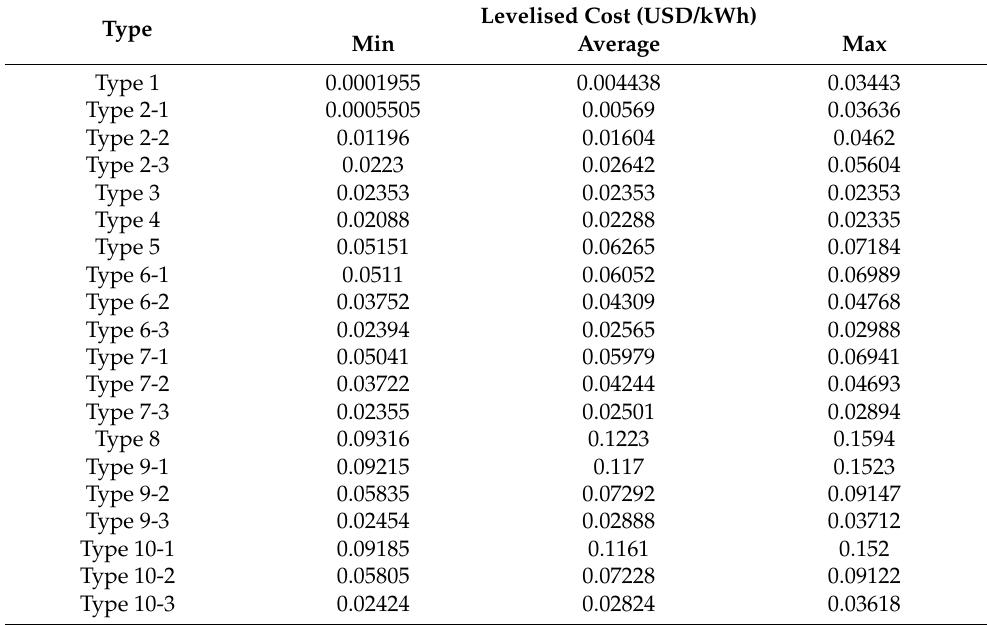
Table 9. Levelised cost (USD/kWh) of fuel